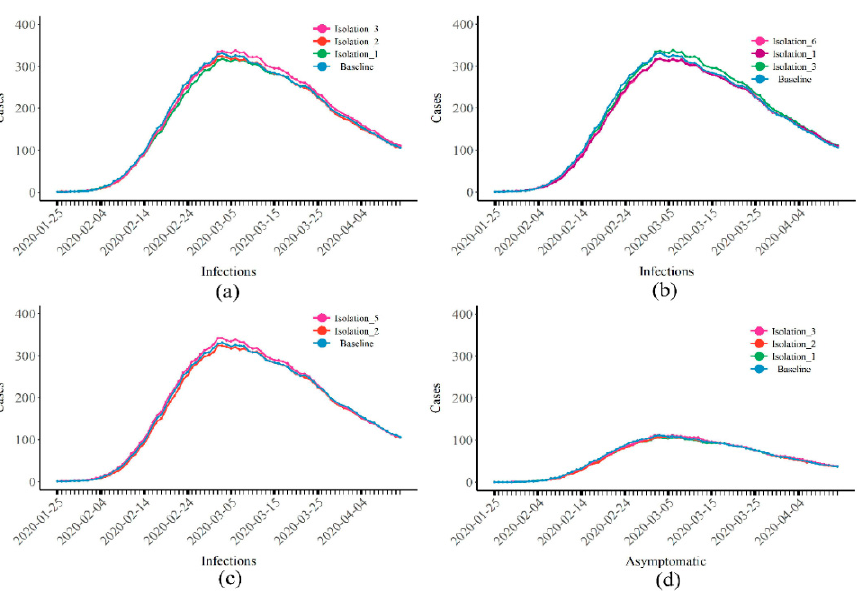
Figure 2. The epidemic curves of COVID-19 when the control measure was isolation only. ( a , b ) The change in the number of infections according to ( a ) the start time or ( b ) the intensity of isolation; ( c ) the number of infections when the social intention was changed; ( d ) the number of asymptomatic infections. The number of cases represents the people in state I on that day, not the number of newly reported cases each day. Table 2. The prevalence of infectious diseases in different scenarios.